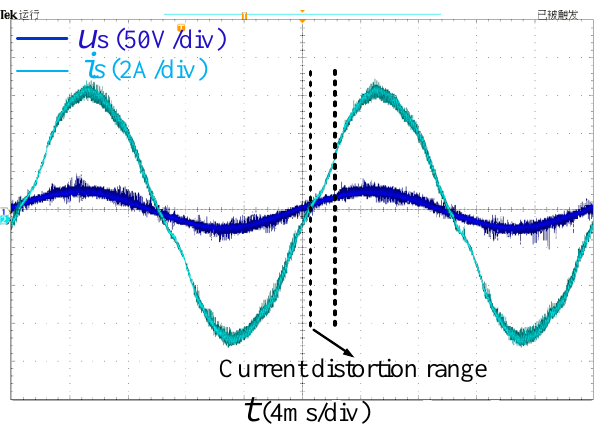
Figure 24. Experiment waveforms of grid voltage and input current under leading power factor.